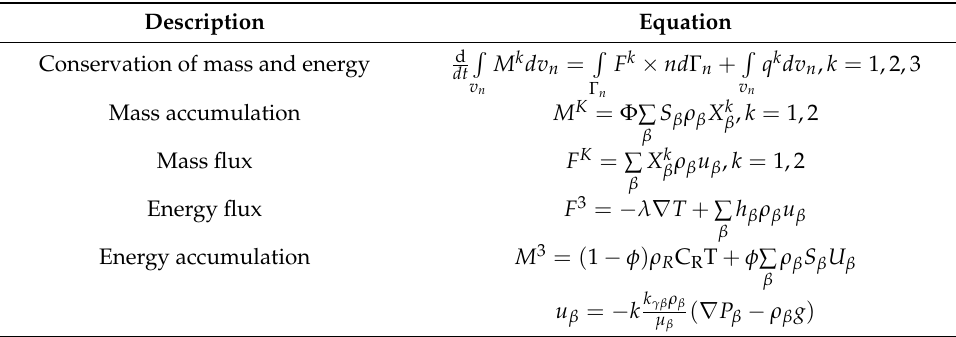
Table 1. Governing equations for TOUGH2/EOS3.